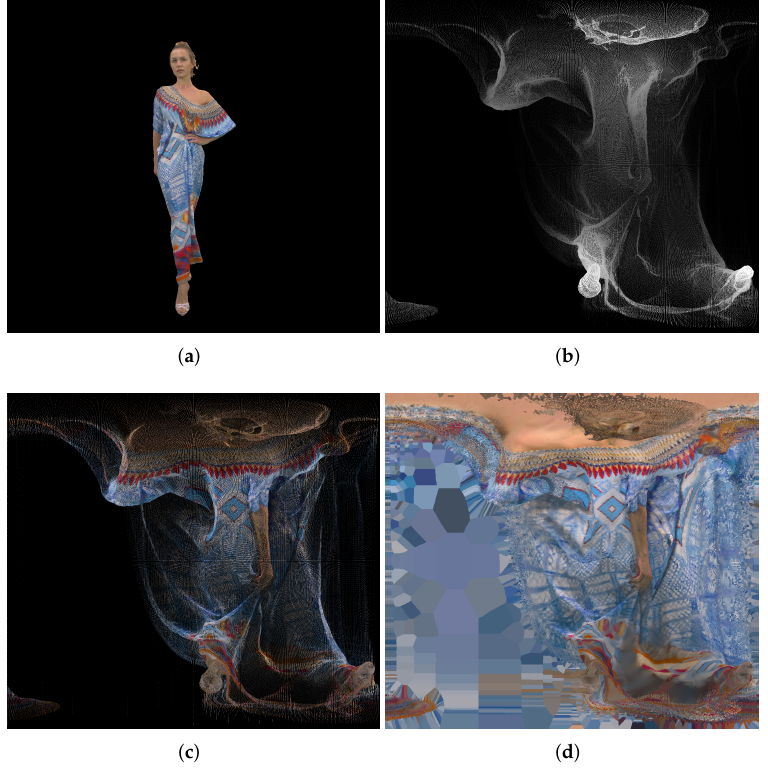
Figure 11. Point clouds to panorama, using Miller projection: ( a ) original point cloud “long- dress_vox10_1060.ply” (799,765 points); ( b ) geometry (1496 × 1344 pixels, 16-bit grayscale); ( c ) texture (1496 × 1344 pixels, 24-bit RGB); ( d ) texture with Voronoi (1496 × 1344 pixels, 24-bit